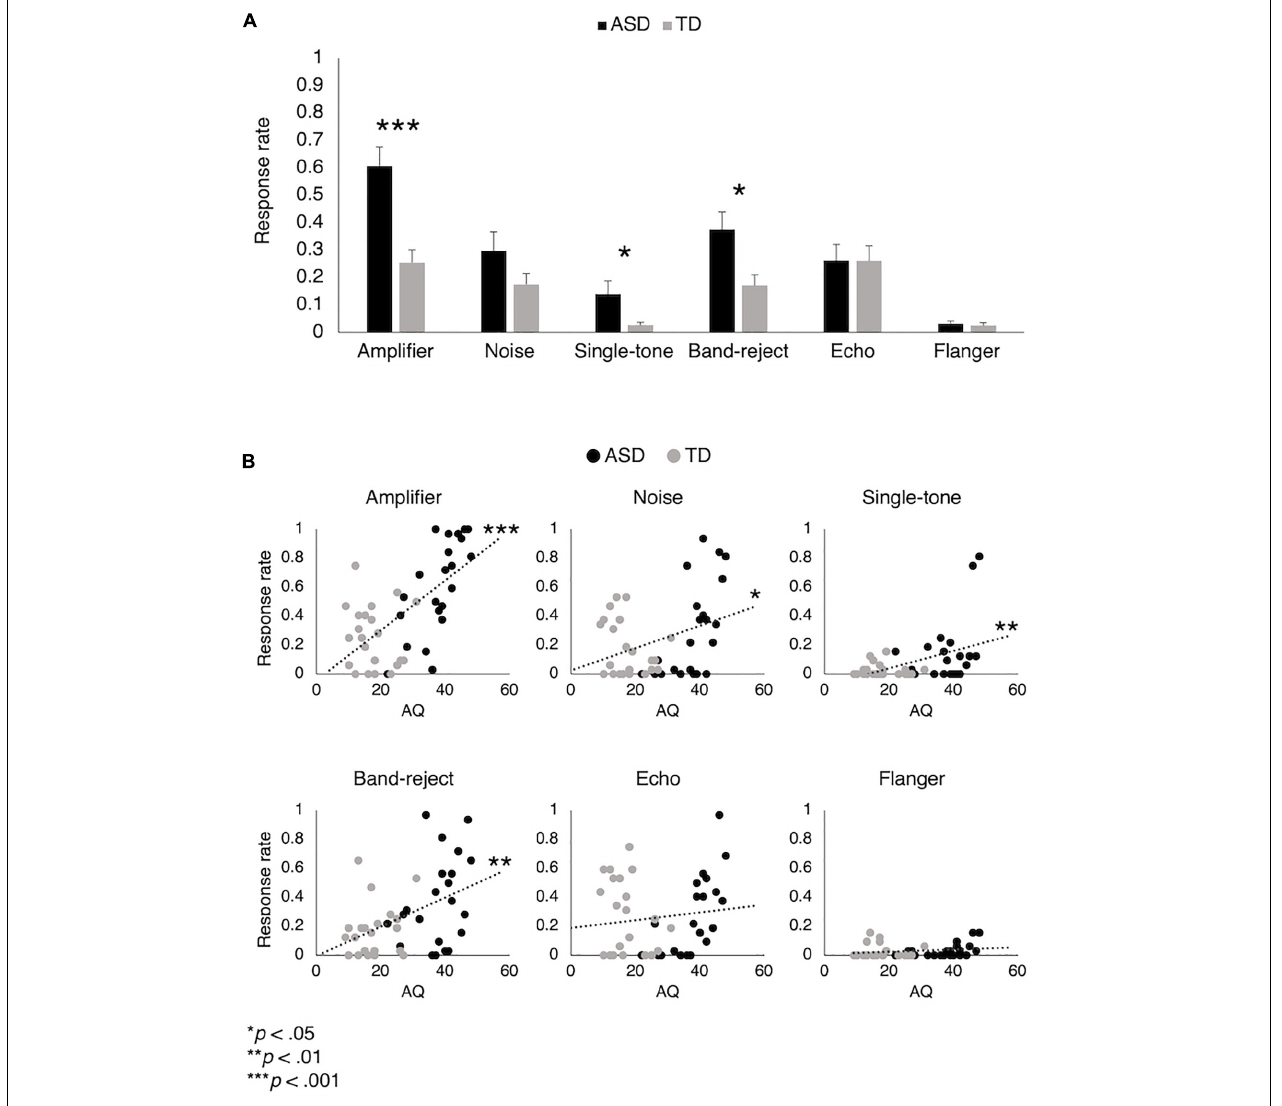
FIGURE 3 | The response rates for the six patterns of atypical auditory perception, which represent how often each signal processing method was selected by the participants. Comparison of the ASD and TD groups is shown in (A) . The ASD group selected the SPM of amplifier, single-tone, and band-reject more frequently than the TD group. The distribution of response rates along with autistic traits are shown in (B) . There is a trend that response rates are positively correlated with autistic